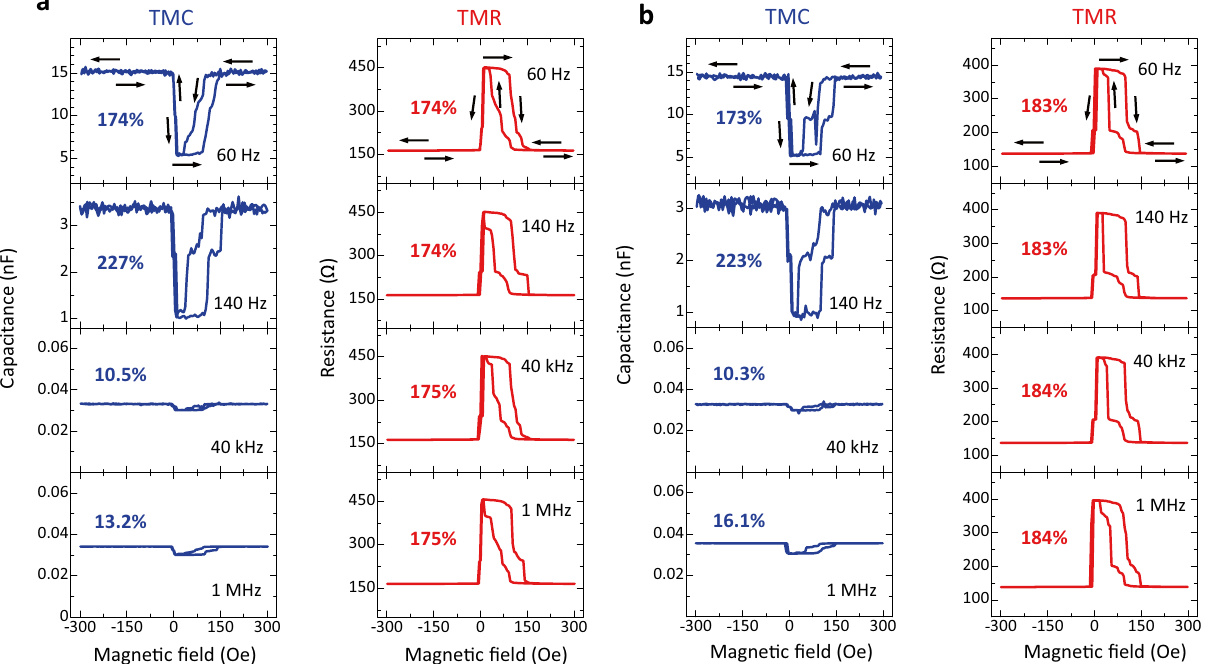
Figure 2. TMC and TMR curves under no bias voltage. ( a ) TMC and TMR curves at 60 Hz, 140 Hz, 40 kHz, and 1 MHz for an Fe/MAO/Fe MTJ (sample A) (Bias voltage ~ 0 V). At 140 Hz, the TMC ratio is 227%, greater than the value in MgO-based MTJs (172%). ( b ) TMC and TMR curves for sample